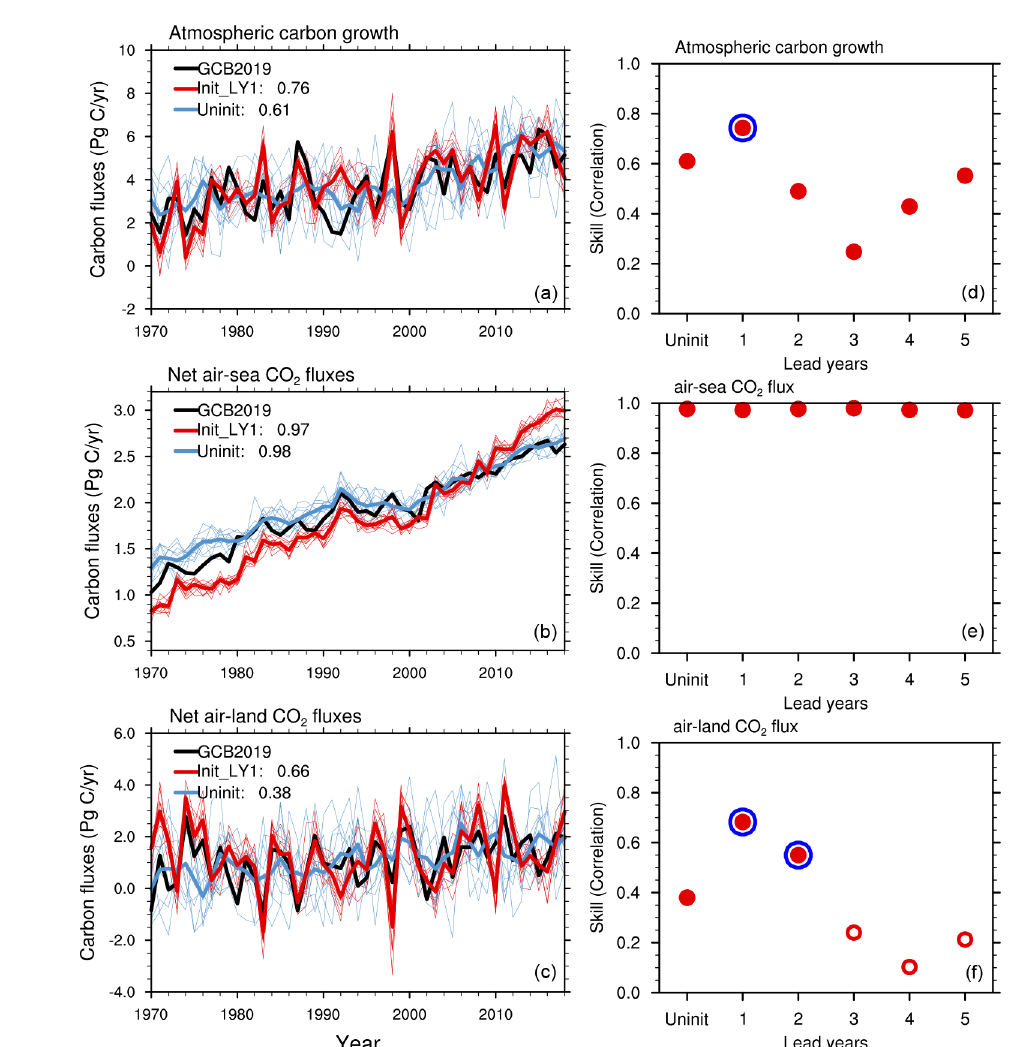
Figure 4. Time series of atmospheric carbon growth rate, i.e., G ATM (a) , net air–sea CO 2 fluxes, i.e., S OCEAN (b) , and net air–land CO 2 fluxes, i.e., E LUC + S LAND (c) , from the initialized simulations at a lead time of 1 year together with values from the uninitialized simulations and estimates from the 2019 Global Carbon Budget (GCB 2019, Friedlingstein et al., 2019). Positive values in (b) and (c) indicate CO 2 fluxes into the ocean or land. The numbers in the legend show the correlation coefficients between the simulations and GCB2019, and the ensemble mean data are used for this correlation calculation. Predictive skill of the atmospheric carbon growth rate, i.e., G ATM (d) , air–sea CO 2 fluxes, i.e., S OCEAN (e) , and net air–land CO 2 fluxes, i.e., E LUC + S LAND (f) , in reference to the Global Carbon Budget (GCB 2019, Friedlingstein et al., 2019). The filled red circles on top of the open red circles show that the predictive skill is significant at a 95% confidence level, and the additional larger blue circles indicate an improved significant predictive skill due to initialization in comparison to the uninitialized simulations. We use a nonparametric bootstrap approach (Goddard et al., 2013) to assess the significance of predictive skill. The results are based on annual mean data for the time period of